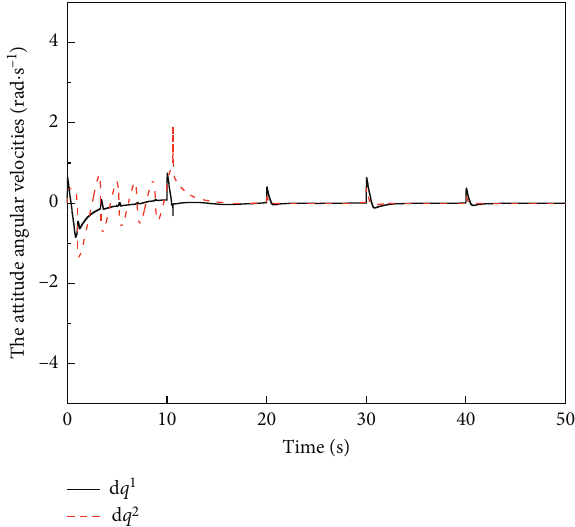
Figure 16: The trajectories of attitude angular velocities